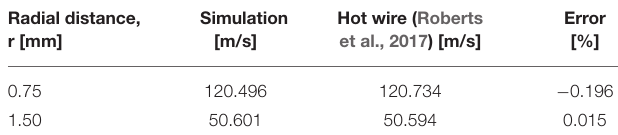
Frontiers in Bioengineering and Biotechnology |